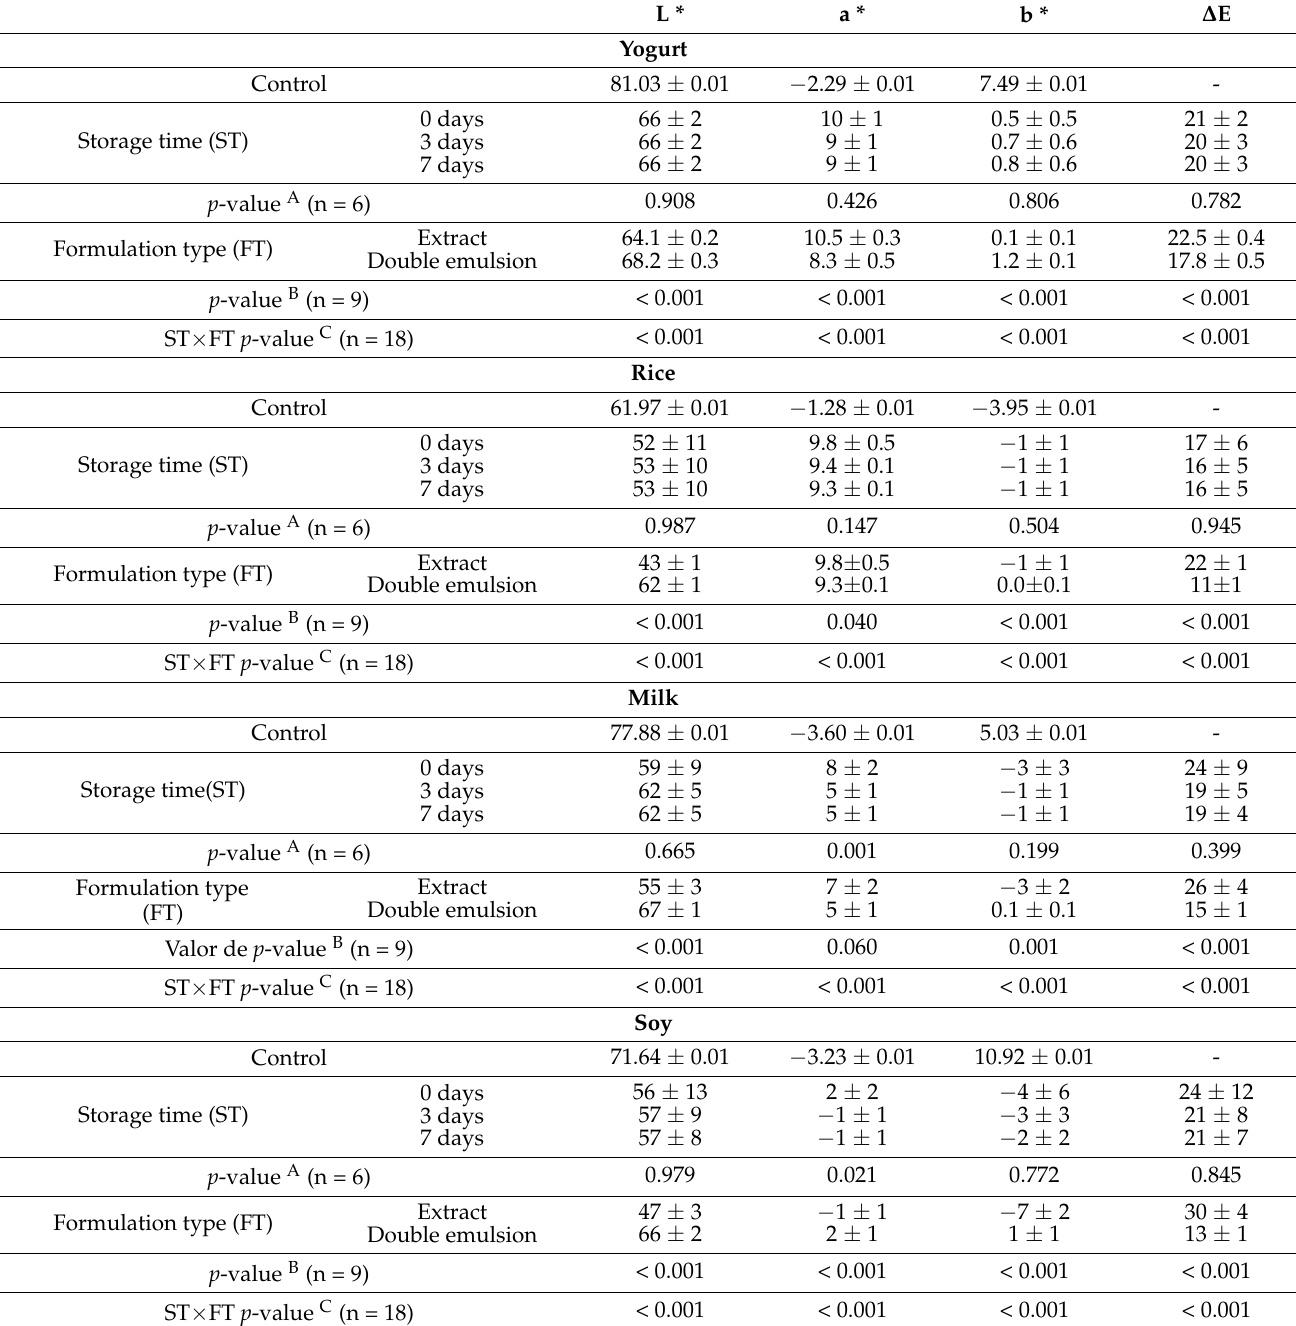
Table 2. Effect of different storage time and formulation type on the colorimetric parameters of the tested beverages stored at 4 ◦